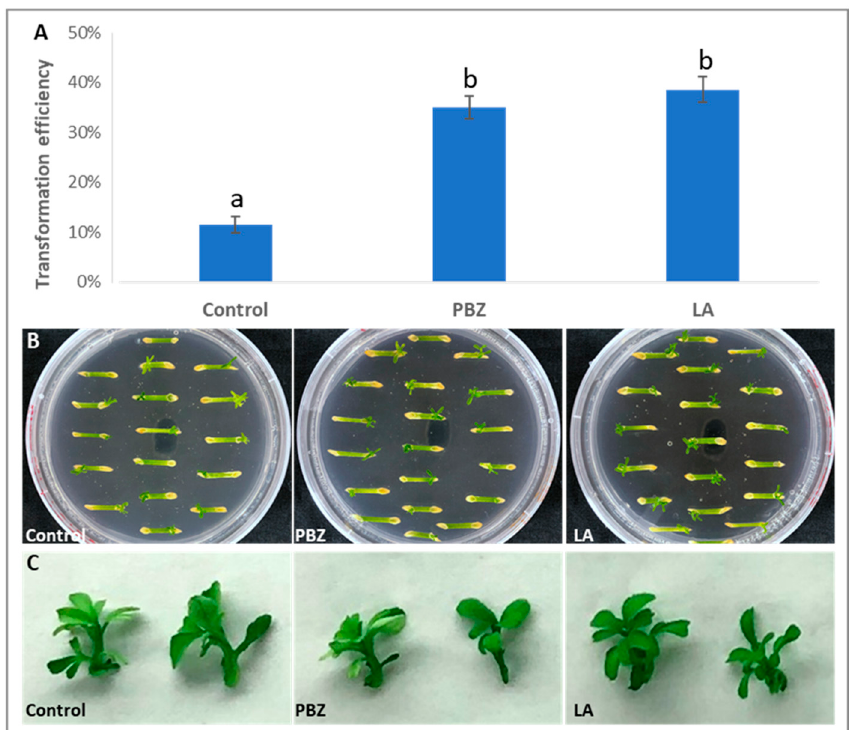
Figure 3. Chemical treatments during co-cultivation increased transformation efficiencies of ‘Carrizo’ citrange. ( A ) Paclobutrazol (PBZ) and lipoic acid (LA) treatments increased transformation efficiencies, respectively. Different letters represent significant difference among different treatments ( p < 0.05, ANOVA, Tukey/LSD). ( B ) Shoot regeneration under kanamycin selection with different chemical treatments 30th post- Agrobacterium -infection. ( C ) Shoots produced from paclobutrazol and lipoic acid treatments 60th post- Agrobacterium -infection displayed no obvious differences in morphology.